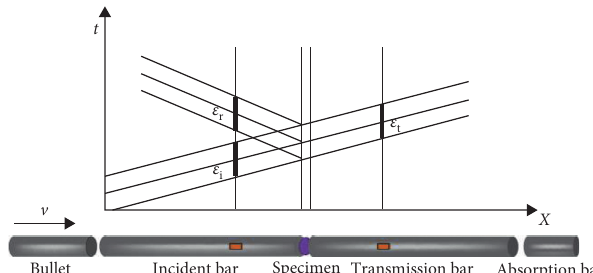
Figure 1: Dynamic Brazilian disc splitting test.